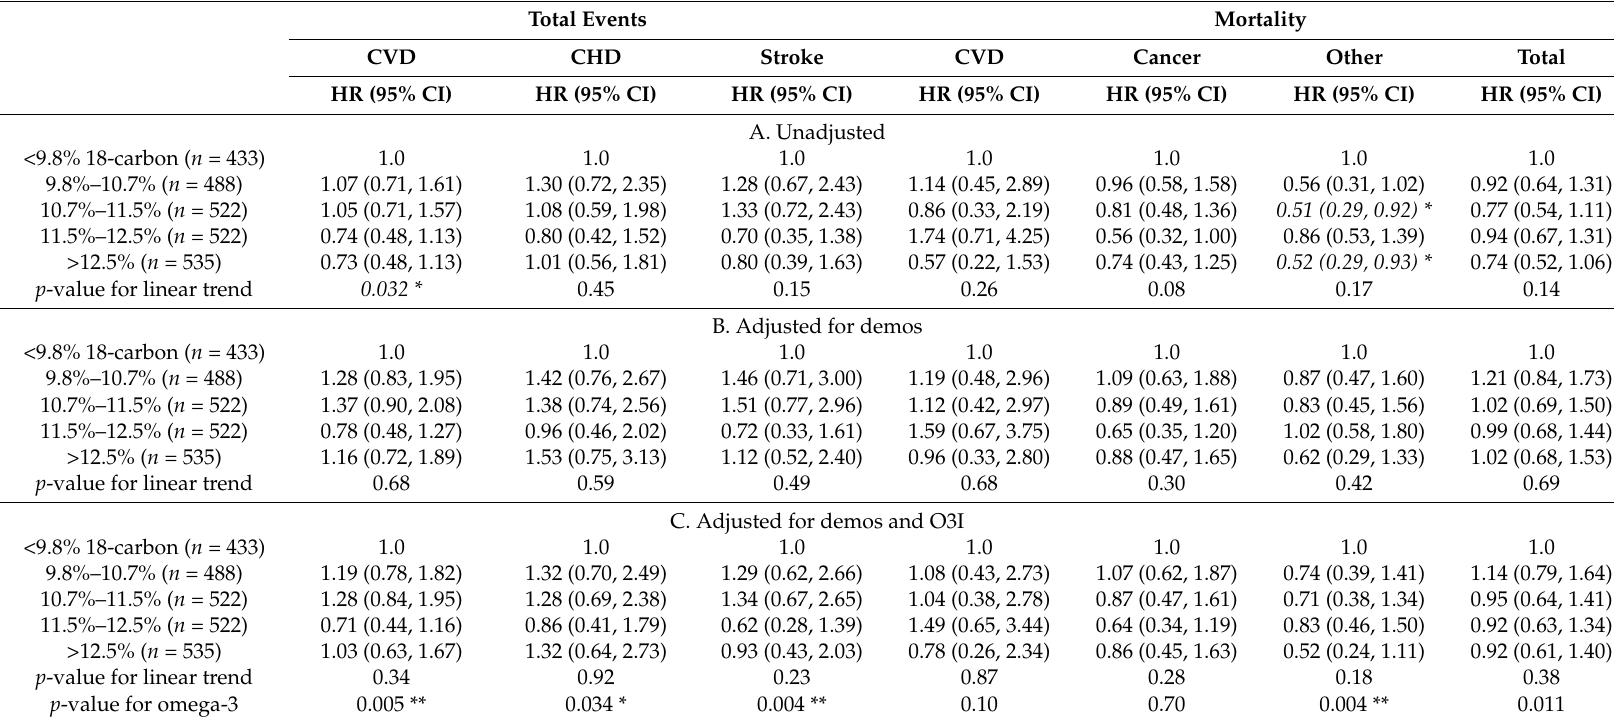
Table 2. Risk of events and mortality by n-6 fatty acid carbon chain length ( n = 2500). ( a ) Eighteen-carbon n-6 fatty acids (18:2n6 + 18:3n6). ( b ) Twenty-carbon n-6 fatty acids (20:2n6 + 20:3n6 + 20:4n6). ( c ) Twenty-two-carbon n-6 fatty acids (22:4n6 +